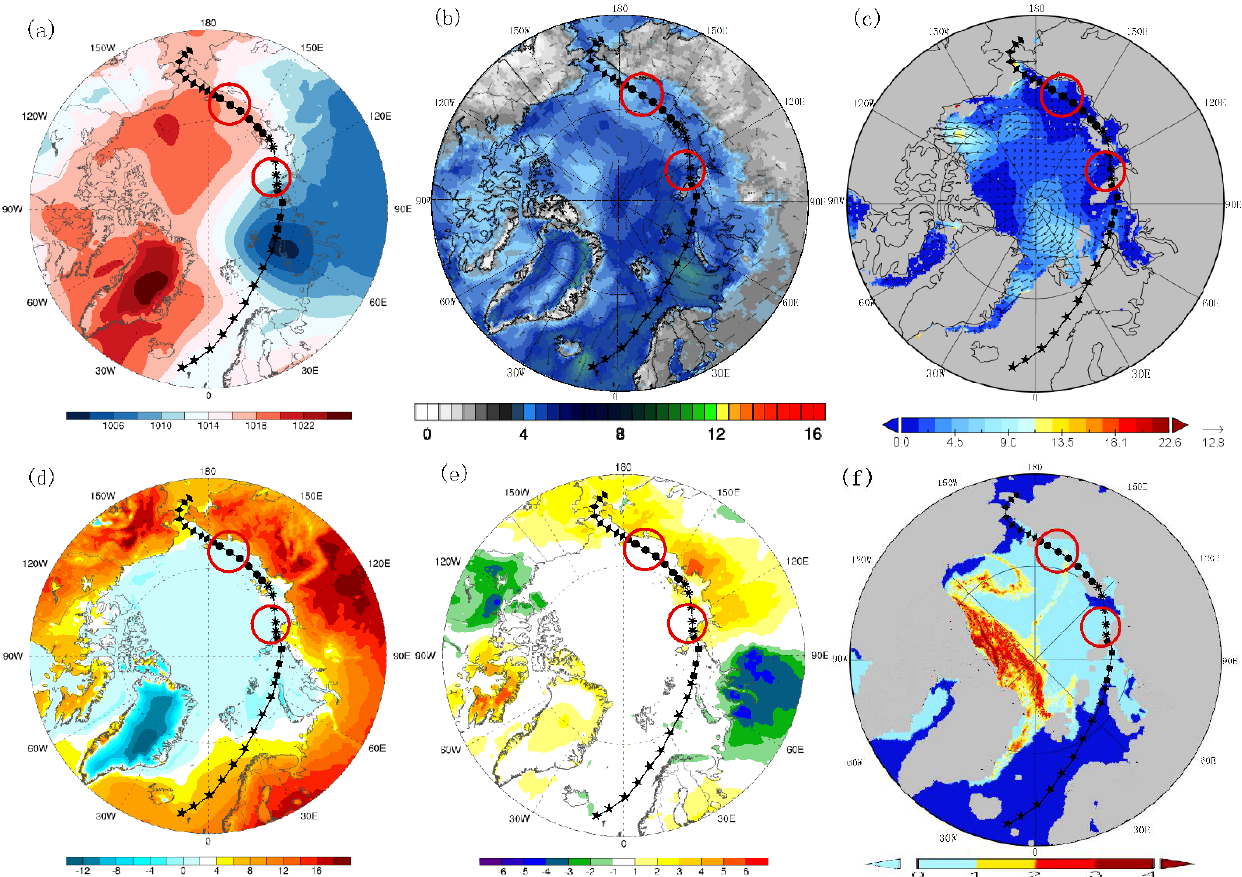
Figure 15. Distribution map of ( a ) sea level pressure (unit: hpa); ( b ) wind field (unit: m −1 ); ( c ) sea ice movement (unit: m −1 ); ( d ) temperature (unit: centigrades); ( e ) temperature anomaly (unit: centigrades) and ( f ) sea ice age (unit: year) in the Arctic summer in June 2019. (The red circles represent the special areas.)